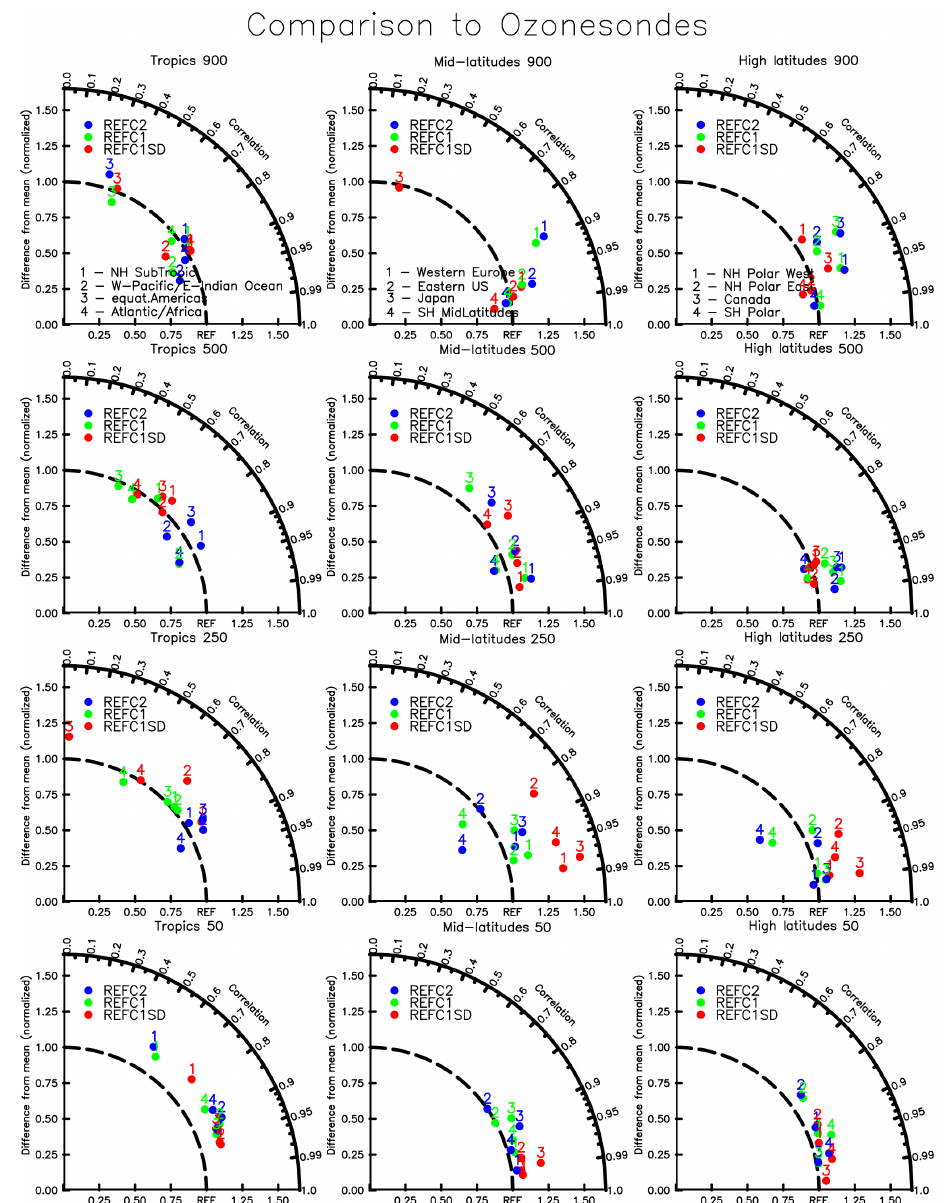
Figure 5. Taylor-like diagram comparing the mean and correlation of the seasonal cycle between observations using a present-day ozonesonde climatology between 1995 and 2011 and model results between 1995 and 2010, interpolated to the same locations as sam- pled by the observations and for different pressure levels, 900hPa (top panel), 500hPa (second panel), 250hPa (third panel) and 50hPa (bottom panel). Different numbers correspond to a specific region, as defined in Tilmes et al. (2012). Left panels: 1 – NH-subtropics; 2 – W-Pacific/eastern Indian Ocean; 3 – equat. Americas; 4 – Atlantic/Africa. Middle panels: 1 – western Europe; 2 – eastern USA; 3 – Japan; 4 – SH mid-latitudes. Right panels: 1 – NH polar west; 2 – NH polar east; 3 – Canada; 4 – SH